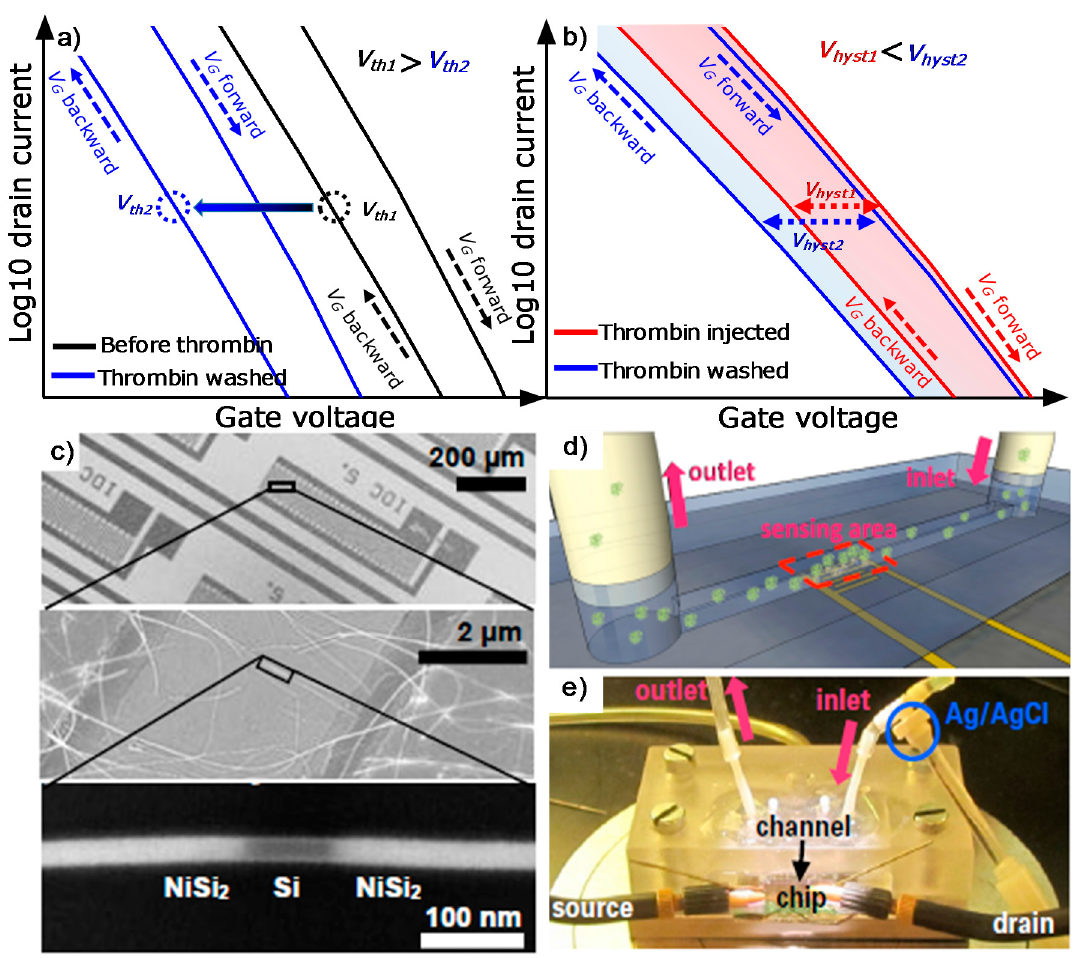
Figure 1. ( a ) Schematic representation of expected shift of the transfer curve upon thrombin binding on the surface. ( b ) Expected shrinkage of the hysteresis in presence of thrombin in solution. ( c ) Details of the biosensor including microelectrodes and nanowires. Bottom panel shows the formed nickel silicide after the annealing process. ( d ) Concept depiction of the fluidic channel on the sensing area, and ( e ) fluidic assembly including mechanical clamping system, tubings, and electrical connections.